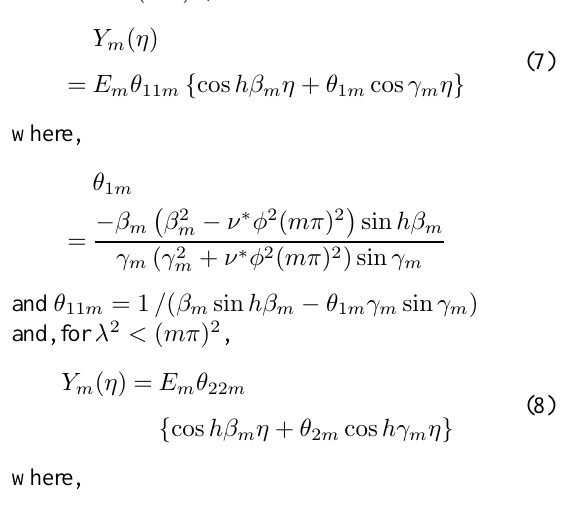
Fig. 2. Schematic representation of the three building blocks employed in solving the bridge deck free vibration problem. For λ 2 > ( mπ ) 2